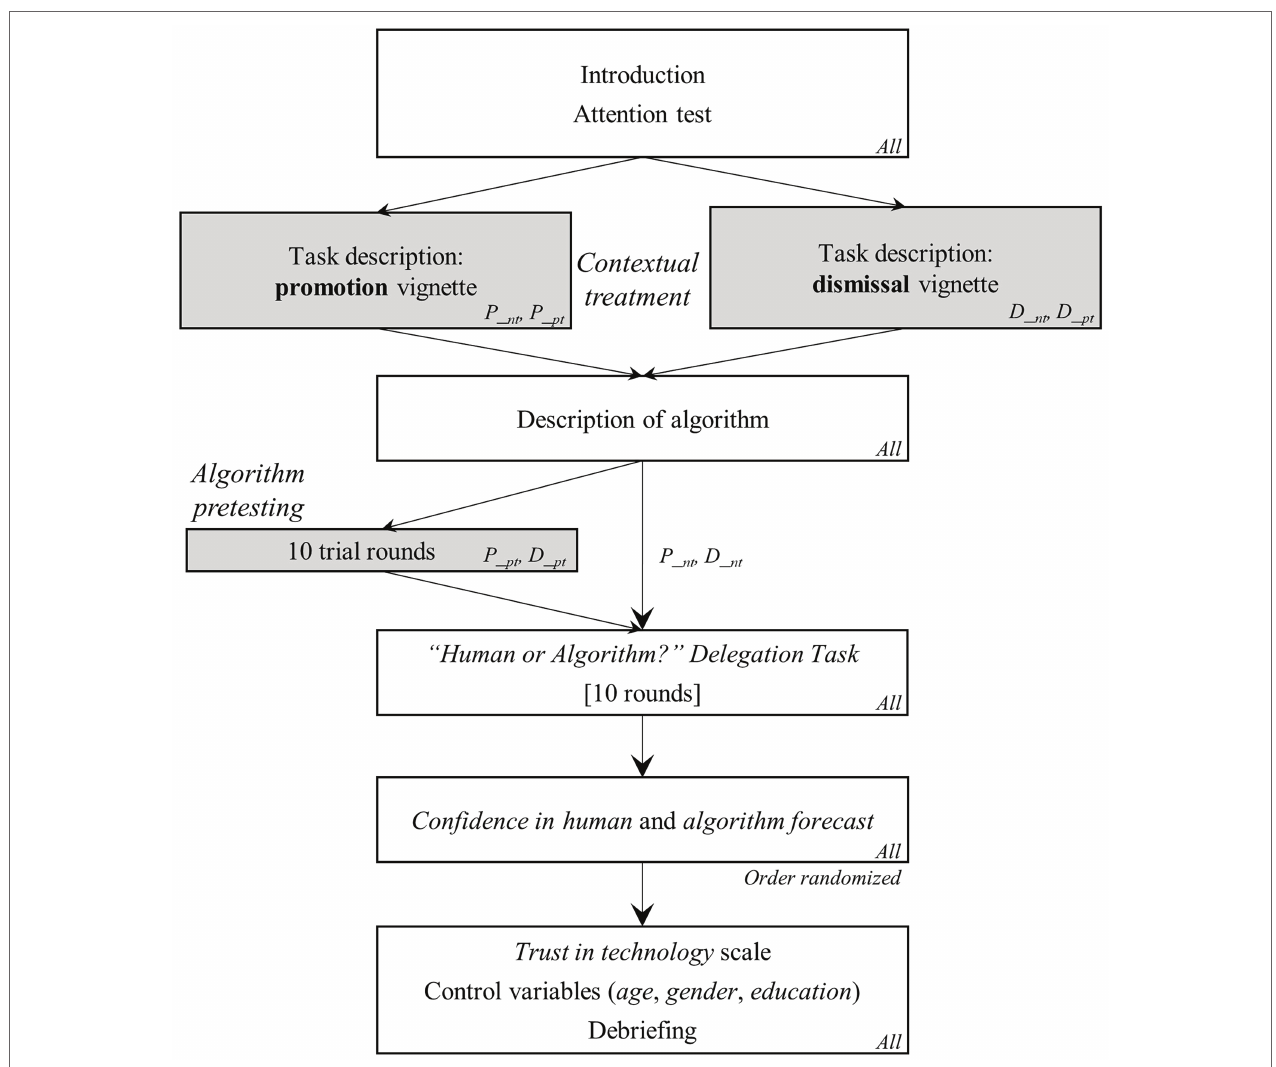
FIGURE 1 | Experimental